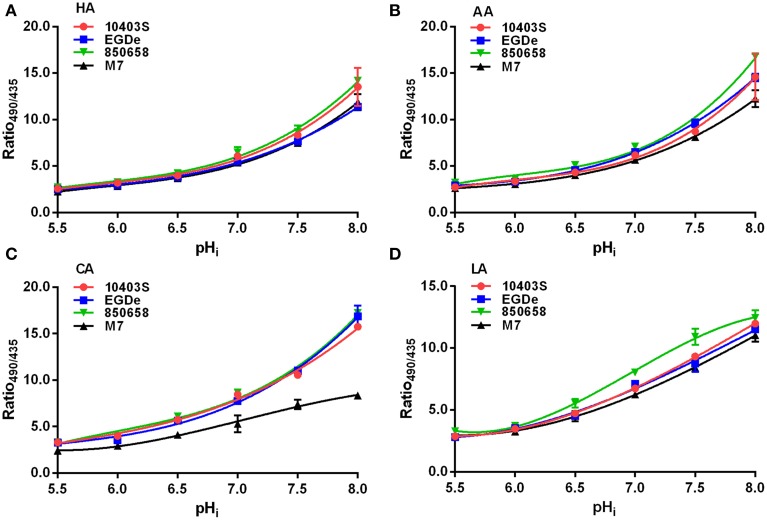
L. monocytogenes intracellular pH (pHi) determination. L. monocytogenes (10403S, EGDe, 850658, and M7) strains were exposed to organic and inorganic acids HA (A), AA (B), CA (C), and LA (D). The cells were equilibrated to pHex by incubating cell preparations with ethanol and resuspending in BHI medium at certain pHs as indicated. The cells were then stained with the fluorescence dye cFDA-SE and measured in a microplate reader at 490 nm and 435 nm respectively. The pHi was plotted against Ratio490/435. HA, Hydrochloric acid; AA, acetic acid; CA, citric acid; LA, lactic acid. Values are expressed as mean ± SD of two independent experiments, each in triplicate wells.